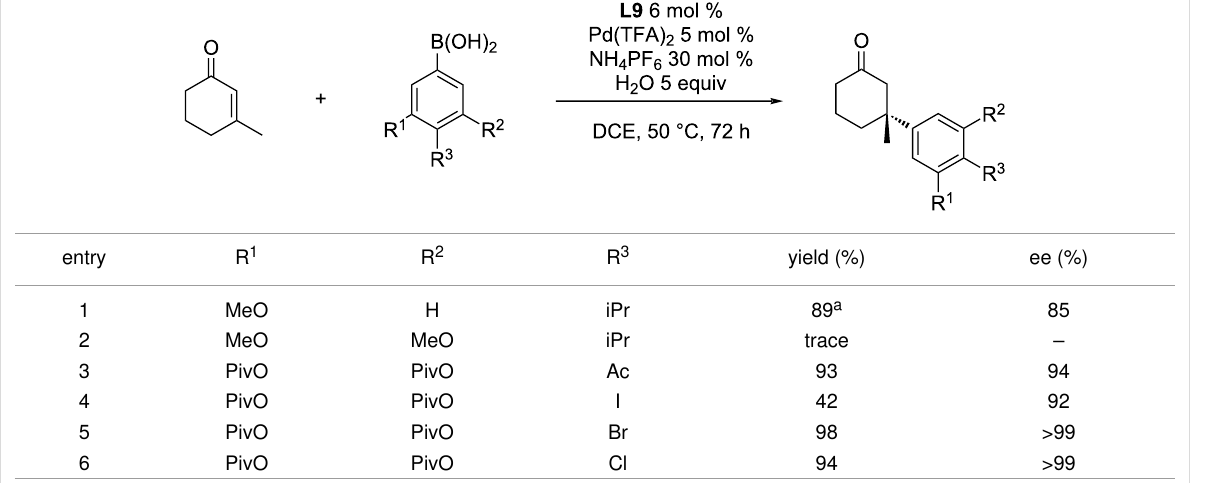
a Reaction performed at 60 °C for 48